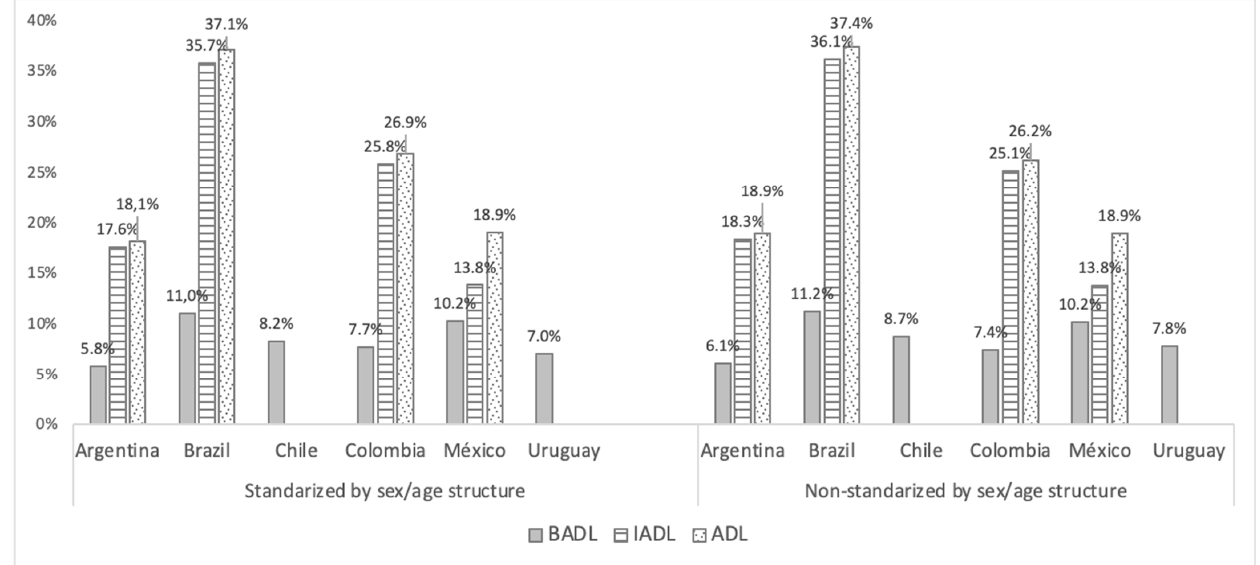
Figure 1. Percentages of older adults (65+) who needs help to perform BADLs, IADLs, or any of both (ADL) by country (standardized and non-standardized). Table 7. Percentages of older adults (65+) who needs help to perform any BADLs, IADLs, or both (ADLs) by sex, age, and country.